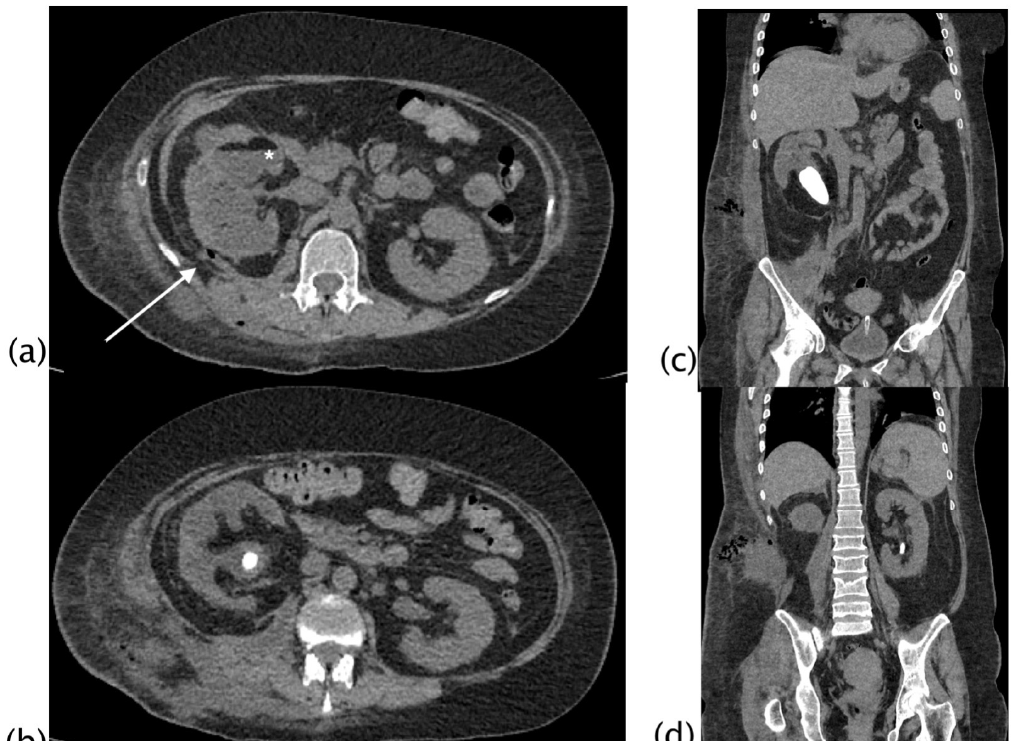
Figure 4. Xanthogranulomatous pyelonephritis Stage III—pararenal form. Non-enhanced CT examination: axial ( a , b ) and coronal MPR reconstruction ( c , d ). The right kidney is increased in volume with reduced parenchymal representation and a “contracted” appearance of the renal pelvis. The renal parenchyma is extremely thinned and characterized by the presence of multiple hypodense areas that cannot be better characterized without contrast agent. ( a ) Within the fluid collection at the anterior middle third of the kidney, a “layer” characterized by fluid (white asterisk) and adipose density (above white asterisk) can be noted, named “xanthoma” and characteristic of the disease. Staghorn lithiasis is present. No significant thickening of the perirenal fat tissue is noted. On the posterior profile of the kidney, a fistulous via with hydro-gas content is visible (( a ), white arrow; ( b )), which carries posteriorly into the psoas and dorsal muscles with fluid collection in the context of the muscle bundles. The fistulous via terminates in the subcutaneous flank soft tissues where fluid collection with gas is present (( d ), MPR